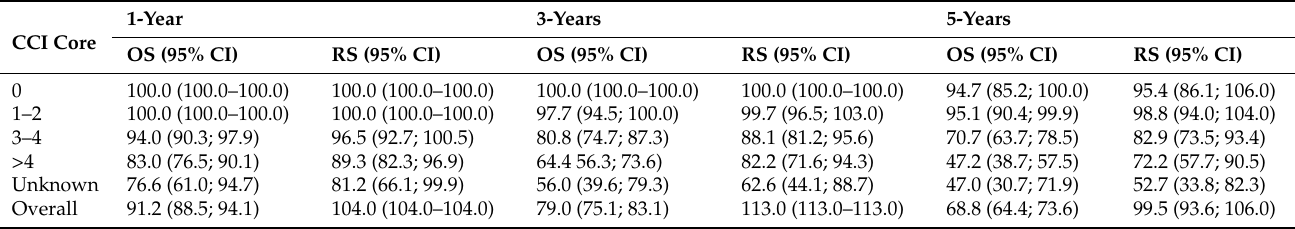
Table 2. Observed and relative survival of chronic lymphocytic leukemia patients according to the Charlson comorbidity index at diagnosis in Girona,